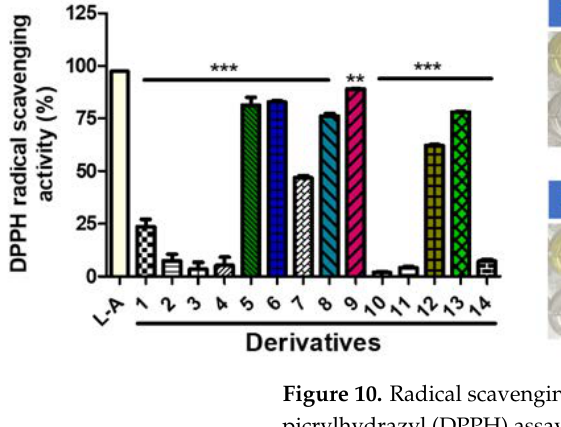
Figure 11. Radical scavenging activities of BABT derivatives 1 – 14 determined using a 2,2′ -azino- bis(3-ethylbenzothiazoline-6-sulfonic acid) (ABTS) assay. BABT derivatives 1 – 14 and Trolox, the